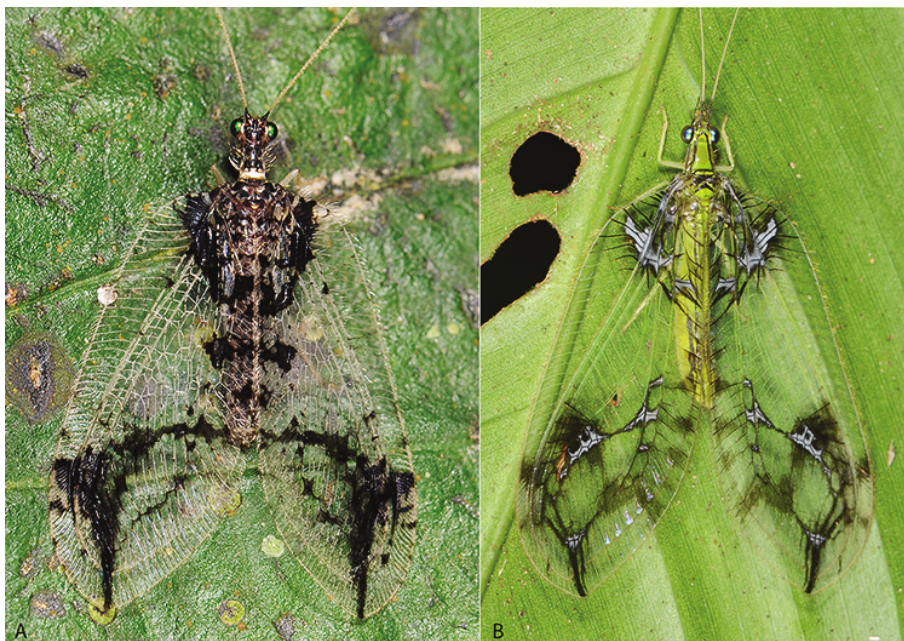
Figure 7. Comparison of Gryposmylus pennyi sp. n. ( A ) (Oriental) and Vieira leschenaulti Navás ( B ) (Chrysopidae) (Neotropical) (photograph credits: A Stephen D. Gaimari B Arthur